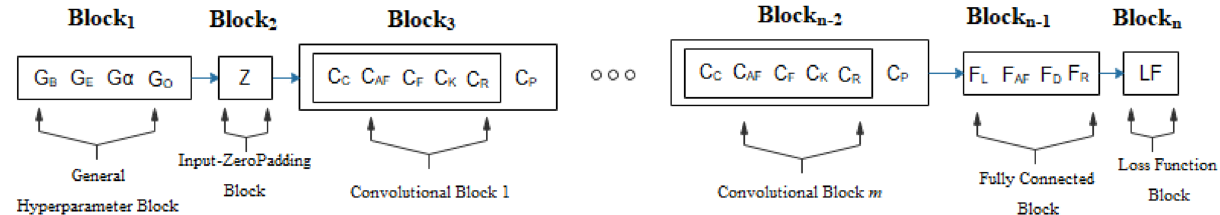
Figure 2. A generic representation of an encoded CNN architecture based on the parameters covered by the search